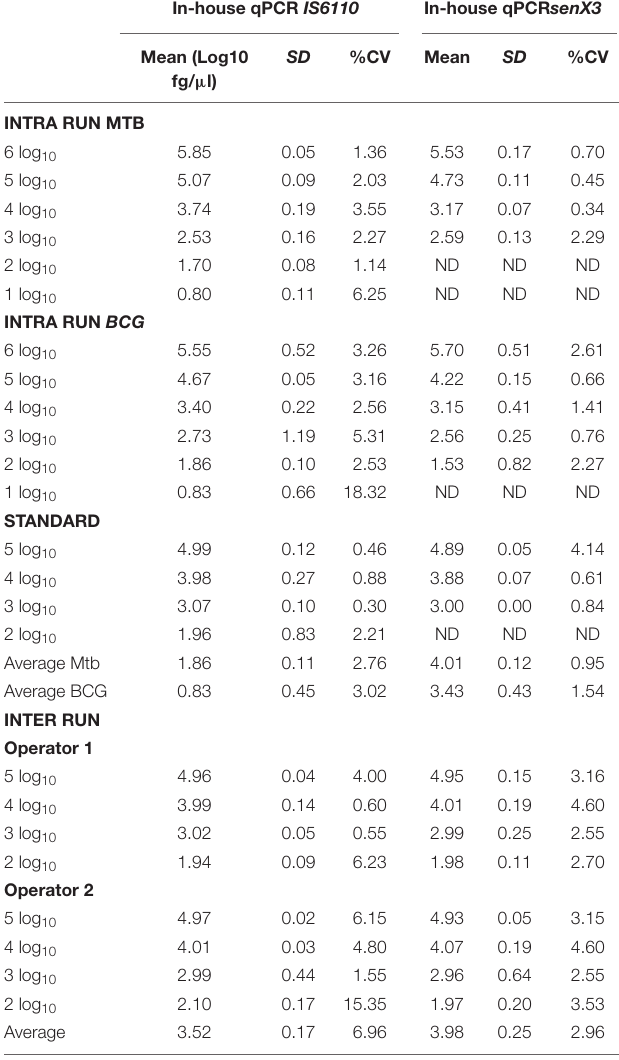
FIGURE 3 | Detection limits of IS6110 and senX3 PCR assays. Curves determined by probit analysis (95% probability detection). (A) IS6110 and senX3 PCR using M. tuberculosis mc 2 7000 DNA. LOD were estimated at 2.03 log 10 (107 copies/ml) and 2.89 log 10 (741 copies/ml), respectively. (B) The detection limit of M. bovis BCG was 2.40 log 10 and 2.90 log 10 for IS6110 and senX3 PCR assays, respectively. (C) IS6110 PCR detection limits using two or three sets of primers compared to a single set of primers based